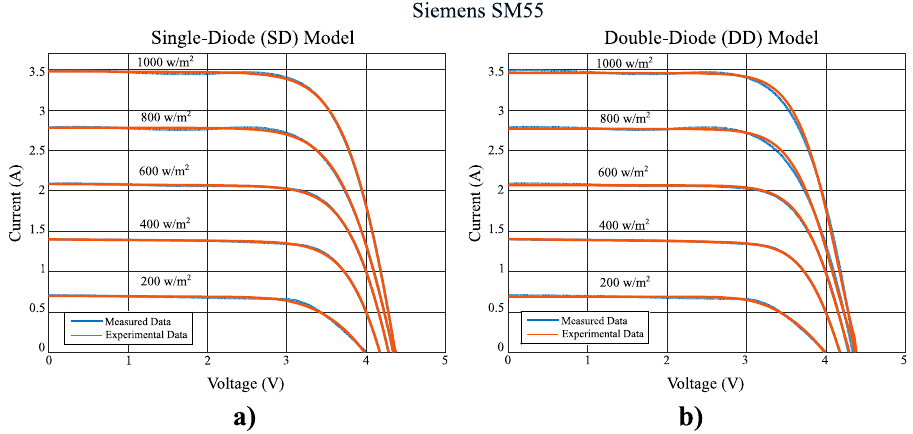
Figure 7. Estimated I-V characteristics curves at different irradiance levels (200, 400, 600, 800 and 1000 W/m 2 ) and fixed cell temperature ( T c = 33 ◦ C ) for an individual cell from a Siemens SM55 Solar Panel. ( a ) SD model and ( b ) DD model. Table 5. SD model PV cell parameters at different solar irradiance levels (200, 400, 600, 800 and 1000 W/m 2 ) and fixed cell temperature ( T c = 33 ◦ C ), extracted by considering an individual PV cell from both the Kyocera KC200GT and Siemens SM55 Solar Panels.